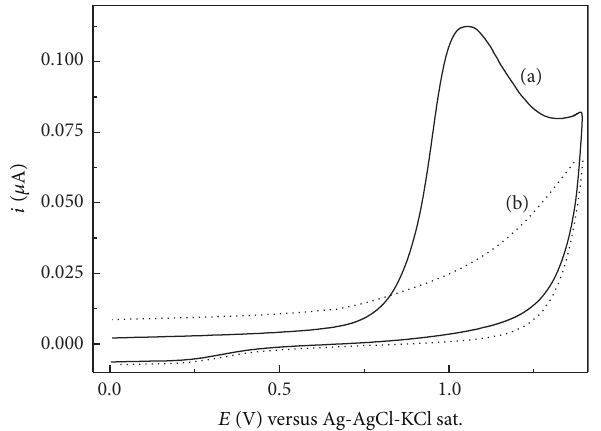
Figure 3: Cyclic voltammograms of (a) MIPpy/GCE sensor before removal of template and (b) MIPpy/GCE in 0.2 M phosphate buffer solution (pH 4.7). ] = 50 mVs −1